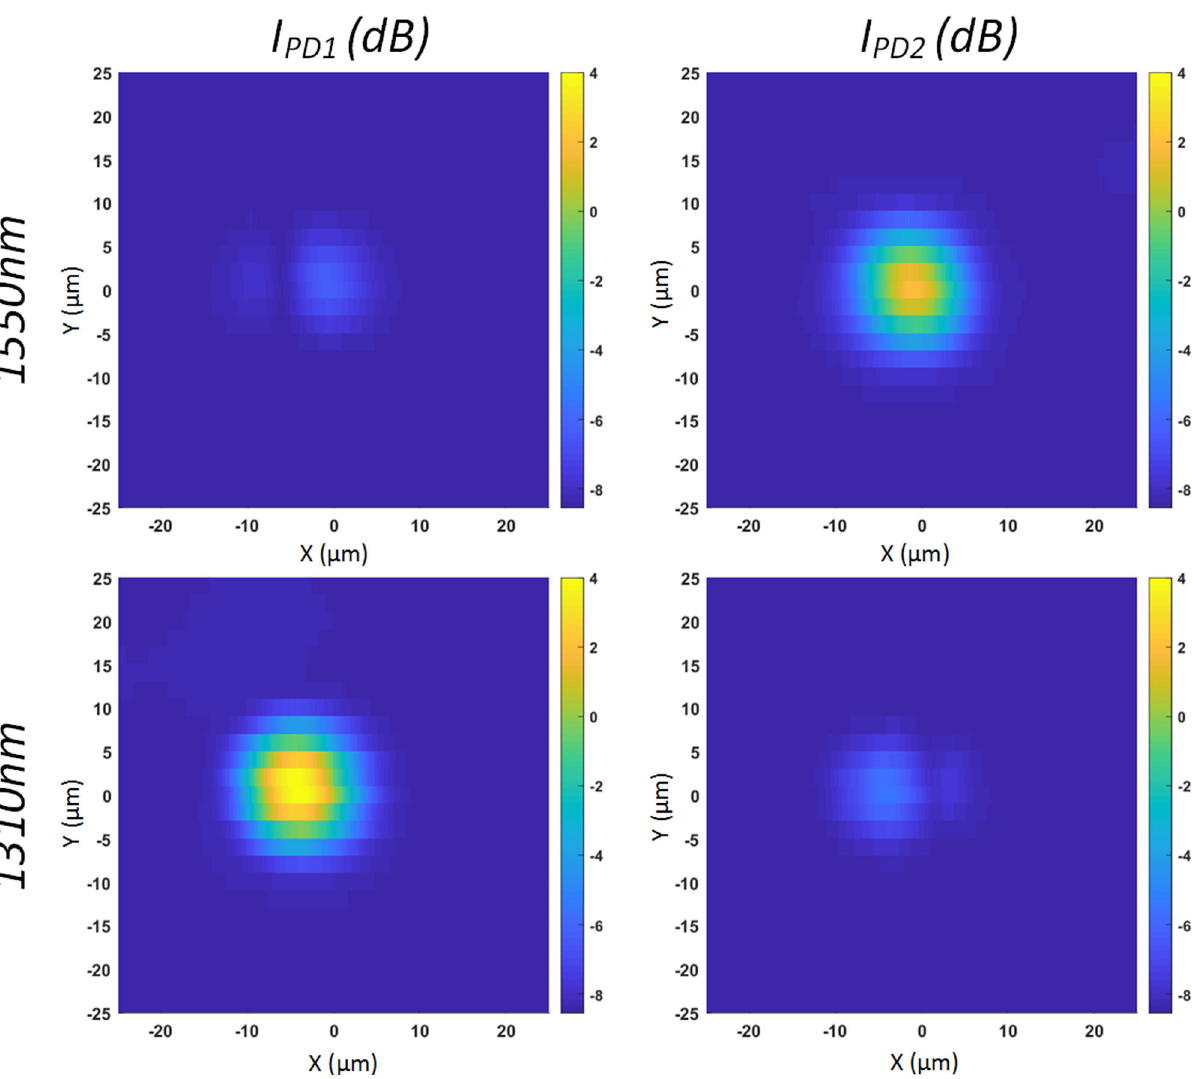
Fig. 5 Coupled output power measurement. Coupled power I PD1 and I PD2 (in dB) measured by the photodiodes PD1 and PD2 displayed in Fig. 4 at the corresponding output ports of the wavelength demultiplexer and for the corresponding wavelengths, 1310 and 1550 nm. The measurement was obtained by laterally scanning the incident fi ber above the device as shown in Fig. 4.